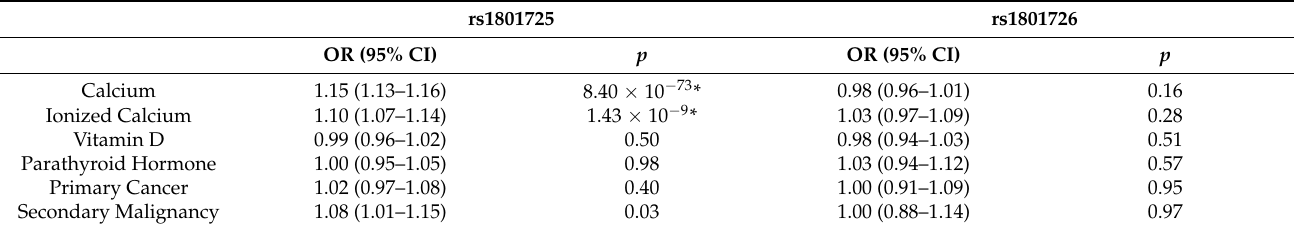
Relationship between CASR exon 7 variants and calcium, PTH, vitamin D, and cancer in European descent